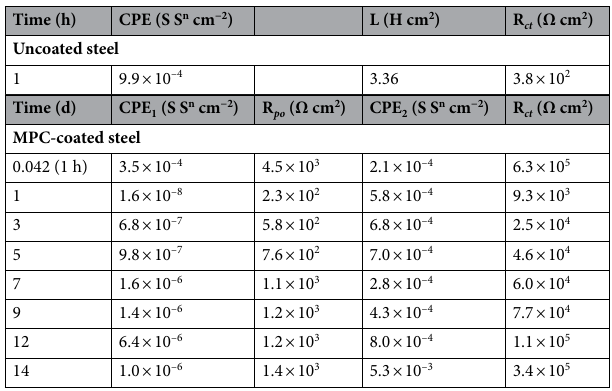
Table 1. Fitting of EIS spectra of mild steel samples to equivalent circuit.